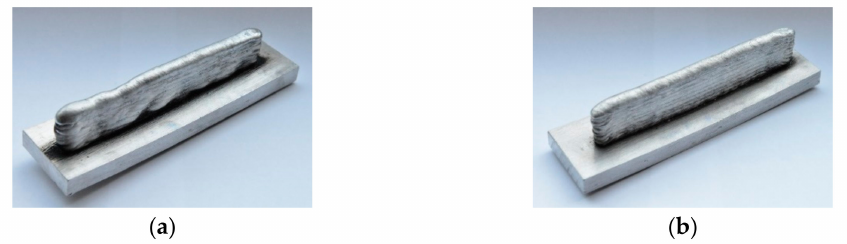
Figure 3. Manufactured samples: ( a ) Al-4047 and ( b )